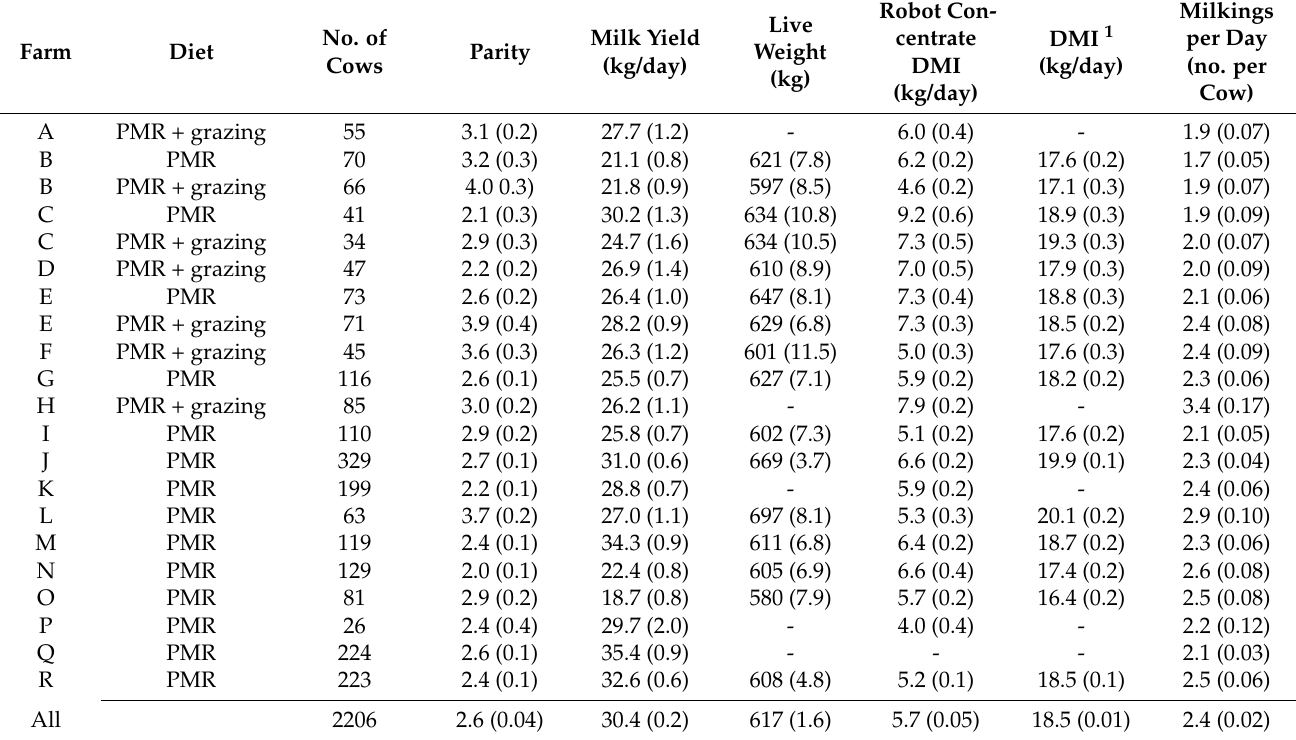
Table 1. Mean (s.e.) parity, milk yield, live weight, robot concentrate, dry matter intake (DMI) and number of milkings per day at each farm (A to R) for cows fed on diets consisting of a partial mixed ration (PMR), or PMR with grazing, plus